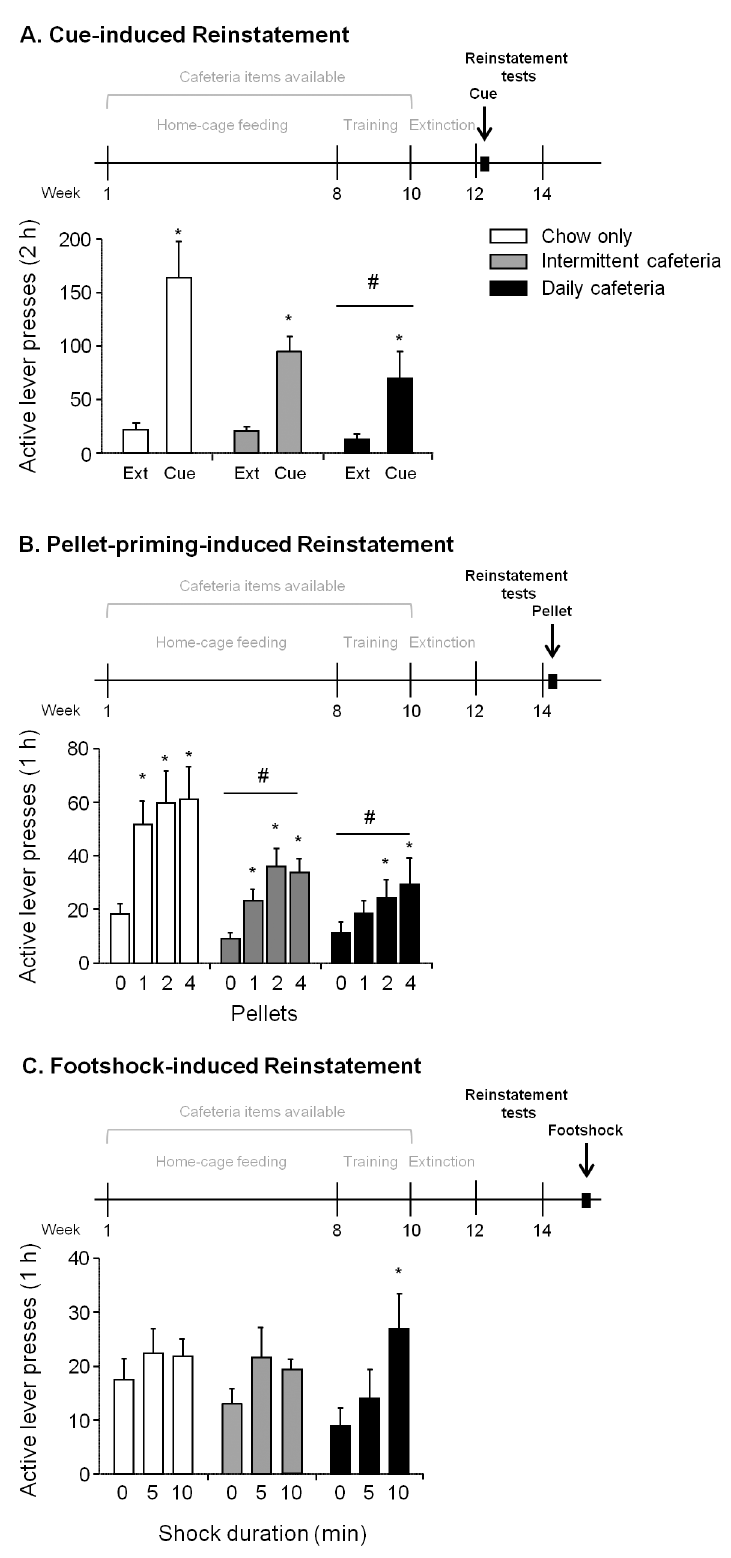
Figure 3. Effect of home-cage diet histories on reinstatement of food seeking. A. Effect of discrete cue presentation on reinstatement. Active lever responding (mean 6 SEM) under extinction (with cue) conditions following a single non-contingent cue presentation at the start of the session. *Different between the last day of extinction (without cue) and cue-test within subject, p , 0.05. # Different in overall lever pressing from chow-only group, p=0.06. B. Effect of pellet priming on reinstatement. Active lever responding (mean 6 SEM) under extinction conditions (with cue) following 1, 2, and 4 non-contingent pellet deliveries at the beginning of an extinction session. *Different between 0 pellet baseline (last one hour